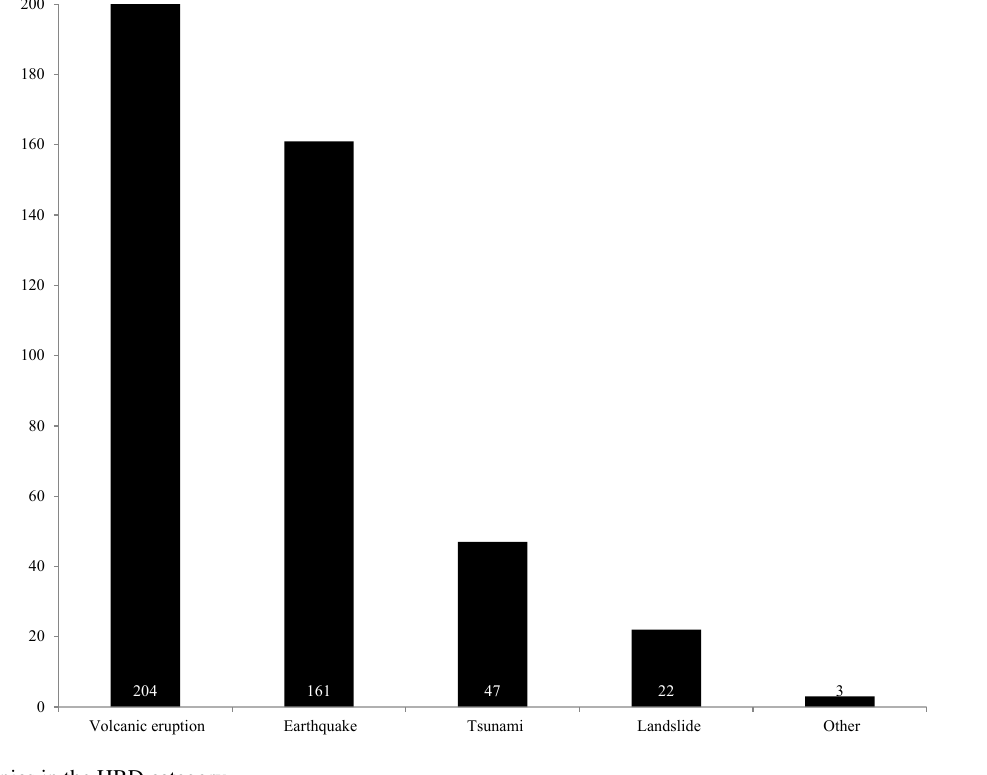
Figure 2. Key topics in the HRD